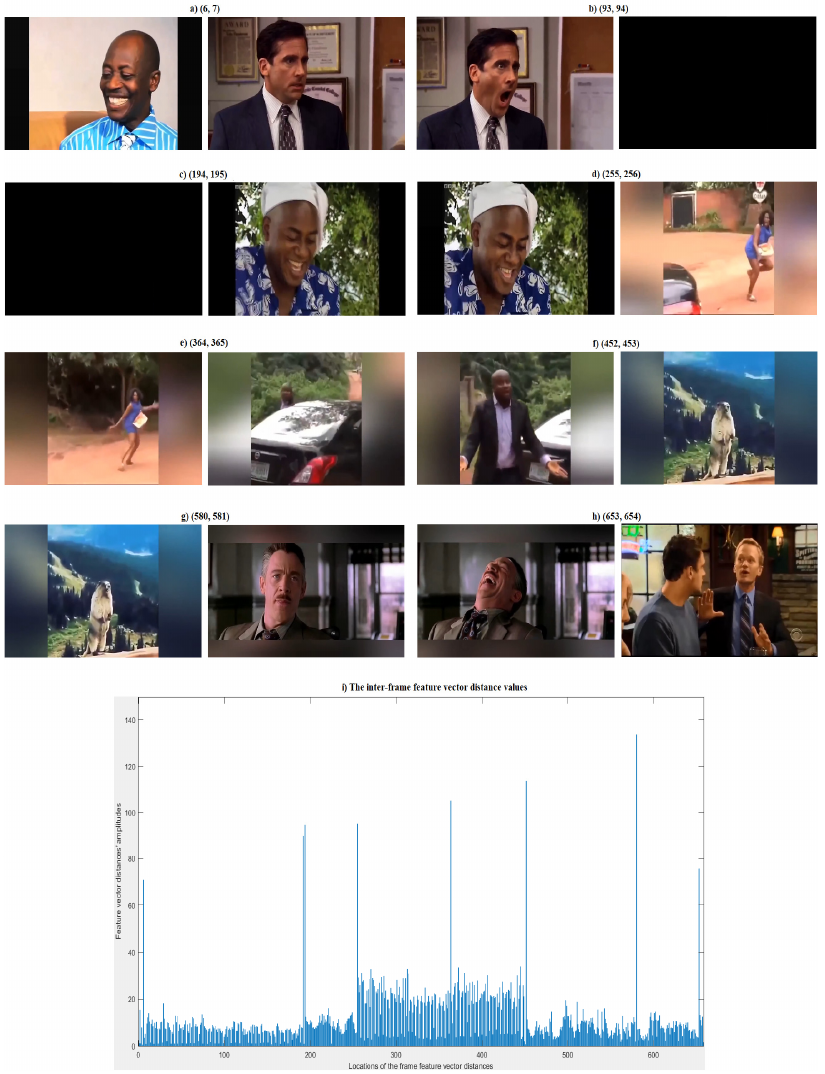
Figure 3. A temporal video segmentation example: ( a – h ) the pairs of frames related to the shot cuts; ( i ) the frame feature vector distance values (the highest ones indicate the cuts).